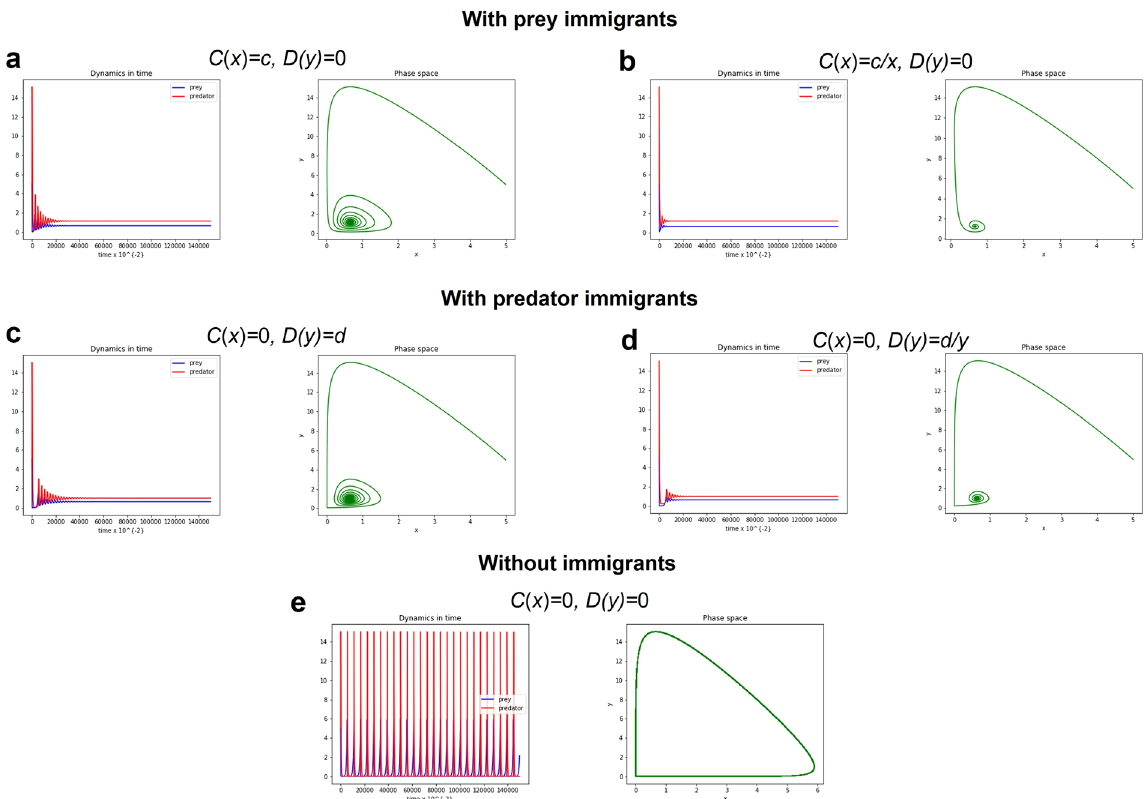
Figure 1. Phase space and long-term population dynamics of the predator-prey population described by LV system (1) with type I functional response and with/without small immigrants. Four cases of the modified LV system (1) with small immigration is compared to the classical LV system. Parameter values: Initial x = 5, Initial y = 5, r = 0.1, a = 0.1, b = 0.3, m = 0.2, c = 0.01, d =